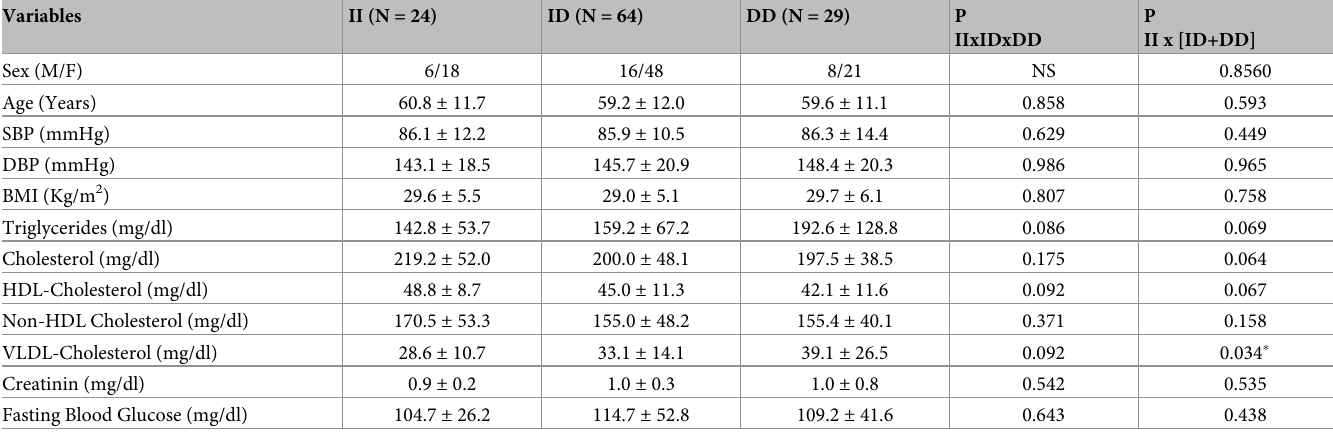
Table 5. Analysis of the influence of ACE I/D polymorphism on clinical-laboratory variables among SAH patients.